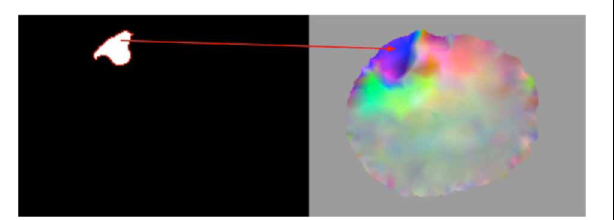
field DF addi (right).